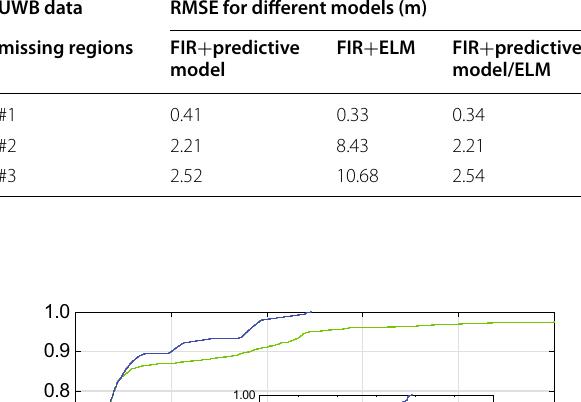
Table 1 Position RMSEs estimated by the FIR FIR predictive mode, and the FIR + UWB data missing regions UWB data RMSE for different models (m) missing regions FIR